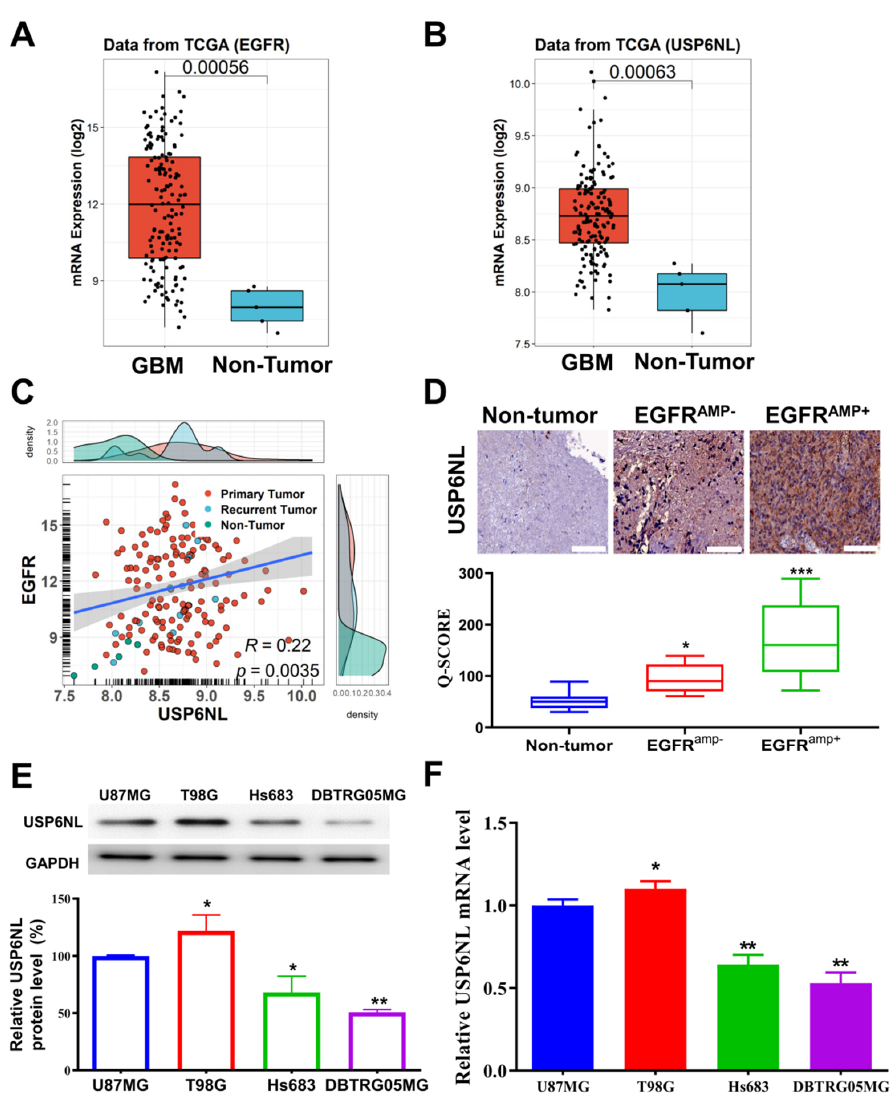
Figure 1. Expression analysis of USP6NL in EGFR amp+/amp − in GBM samples. ( A , B ) mRNA level of EGFR and USP6NL in patients with GBM from The Cancer Genome Atlas (TCGA) dataset (n = 207) and corresponding healthy samples (n = 163). ( C ) Correlation analysis of mRNA expression of EGFR and USP6NL in the TCGA-GBM database. ( D ) Immunohistochemistry analysis of USP6NL expression in EGFR-amplified samples compared with their nonamplified SHH-GBM cohort (n = 60) (original magnification × 100). ( E ) Protein and ( F ) mRNA levels of USP6NL in four (U87MG, T98G, Hs683, and DBTRG05MG) GBM cell lines were assessed using Western blot and RT-PCR methods, respectively. *** p < 0.001, ** p < 0.01, * p <